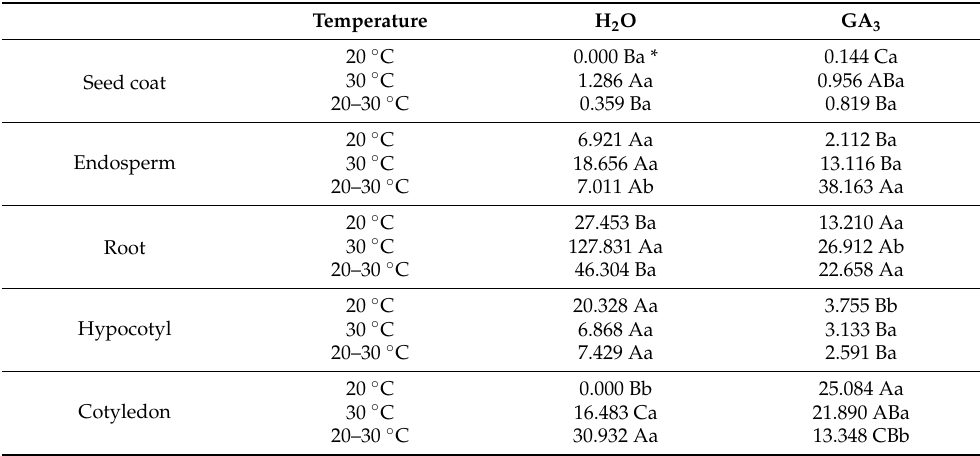
Table 6. Liriodenine concentration ( µ g g − 1 dry mass) in seedling structures (seed coat, endosperm, root, hypocotyl, and cotyledon) originated from Annona x atemoya Mabb. cv. ‘Gefner’ seeds immersed for 36 h (with H 2 O or GA 3 ) at temperatures of 20 ◦ C, 30 ◦ C, and 20–30 ◦ C and kept at the same temperatures during early